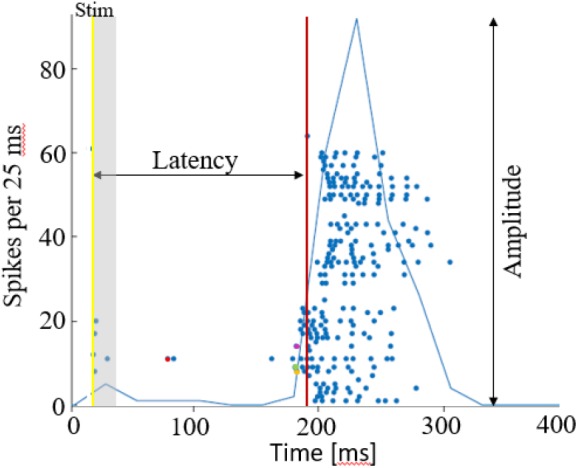
Network synchronization parameters. A raster plot of a single network burst, where each dot depicts an action potential by the time and electrode index. The latency is calculated as the time from stimulation time (yellow line), to the synchronization detection (red line). The amplitude of synchronization is the maximal sum of action potentials, in 25 ms. Action potentials occurring within the first 15 ms after stimulation are excluded from the propagation path analysis, assuming these are caused by direct excitation from the stimulation current. The propagation path is then identified by the order of responding electrodes, in this case it the first 4 are electrodes 11 (red), 9 (green), 8 (yellow), 14 (purple). The propagation speed/delay, would be in this case the time interval between these first spikes occurring in each of the electrodes.